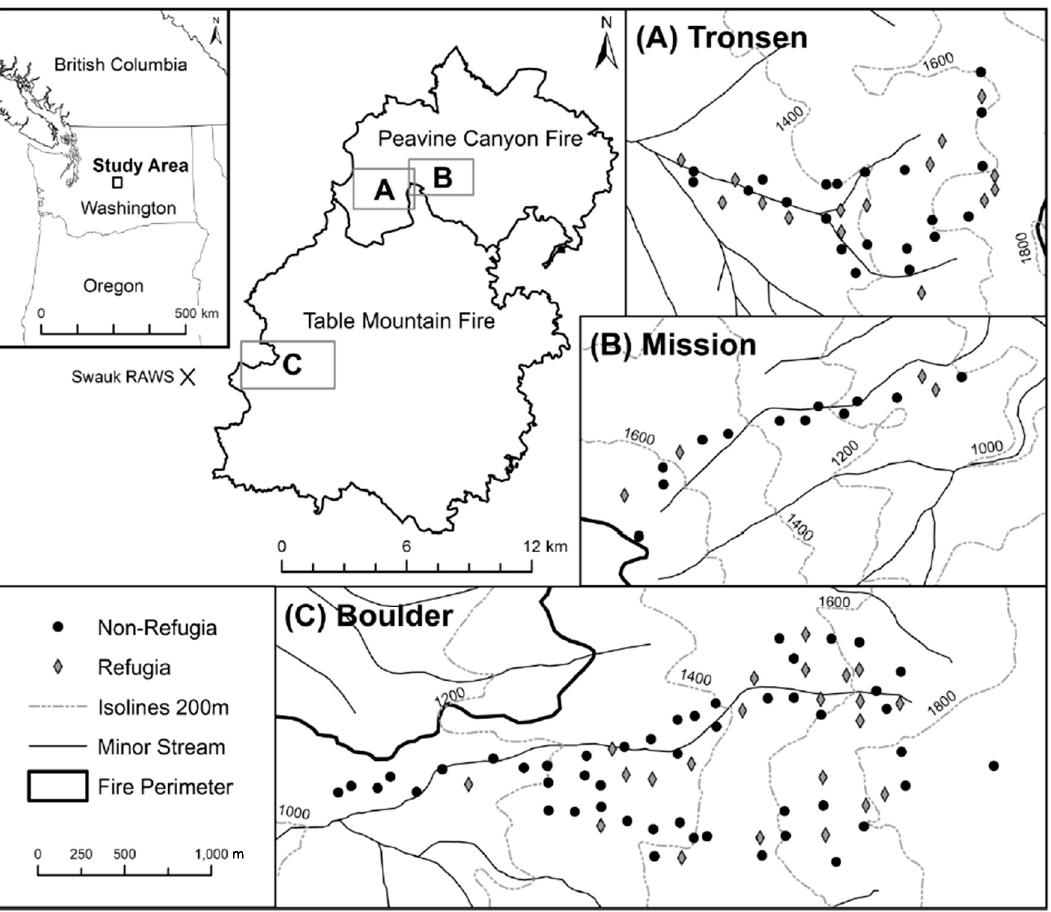
Figure 1. Study area in the east Cascades of central Washington State, USA, with burn perimeters of the 2012 Peavine Canyon and Table Mountain fires and spatial locations of the Camp et al. [11] classified refugial (diamonds) and non-refugial (circles) plots in the three study drainages (Tronsen, Mission, and Boulder).